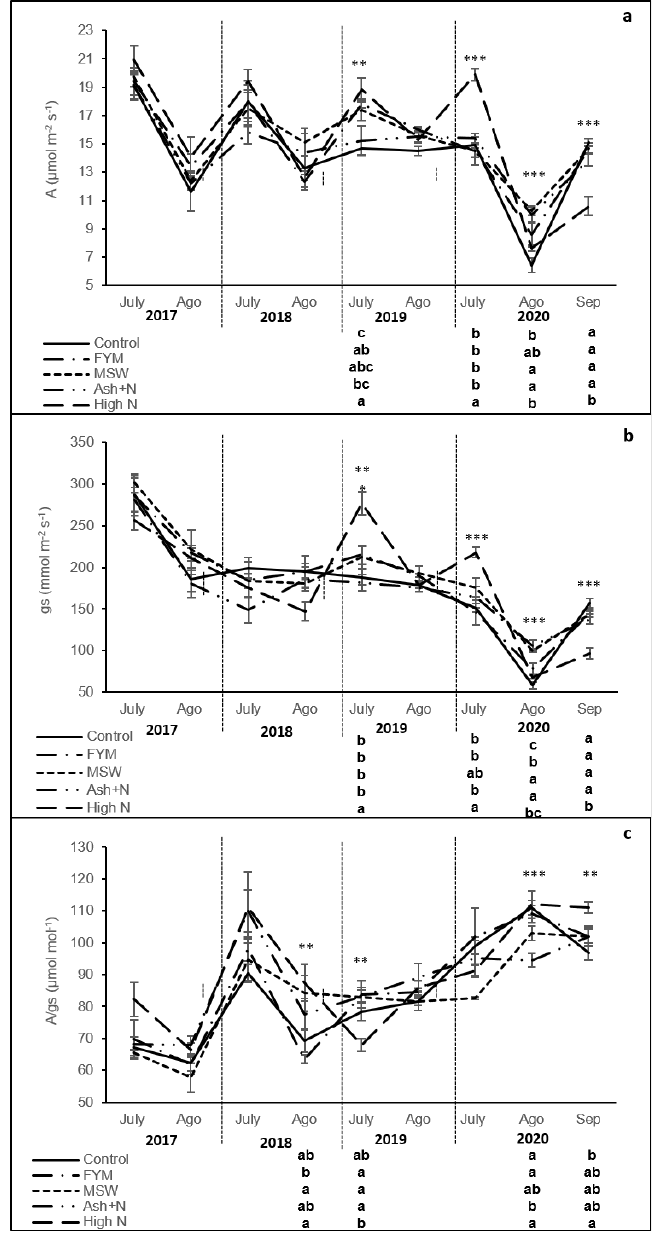
Figure 4. Net photosynthetic rate (a), stomatal conductance (b) and intrinsic water use efficiency (c) from July 2017 to September 2020 as a function of fertilizer treatments: control, compound NPK (50 kg ha - 1 of N, P2O5 and K2O); FYM, farmyard manure (rate equivalent of 50 kg N ha −1 ); MSW, municipal solid waste (rate equivalent of 50 kg N ha −1 ); Ash+N, bottom ash (4 t dw ha −1 ) plus 50 kg N ha −1 ; and High N, high N rate (120 kg N ha −1 and 50 kg ha −1 P2O5 and K2O). ** ( p < 0.01) and *** ( p < 0.001) are the results of analysis of variance. Within each date, means followed by the same letter are not significantly different by Tukey HSD test (α = 0.005). Vertical bars are standard errors. Leaf N concentration varied significantly between fertilizer treatments in five of the seven dates of samplings (Figure 5). The values of the High N treatment appeared sys- tematically at the top of the figure, while the lines of FYM and MSW tended to be observed at the bottom of the figure. In general, the values appeared positioned in the lower middle part or even below the lower limit of the sufficiency range. Leaf P levels also differed significantly between treatments in five of the seven sampling dates. In this case, Ash+N, MSW and FYM appeared frequently at the top of the figure, whereas High N treatment frequently appeared at the bottom. Leaf P concentrations were generally found within the